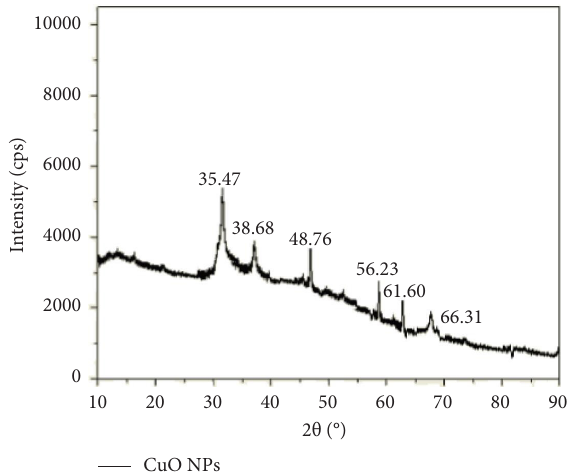
Figure 6: X-ray difraction study of CuO nanoparticle.